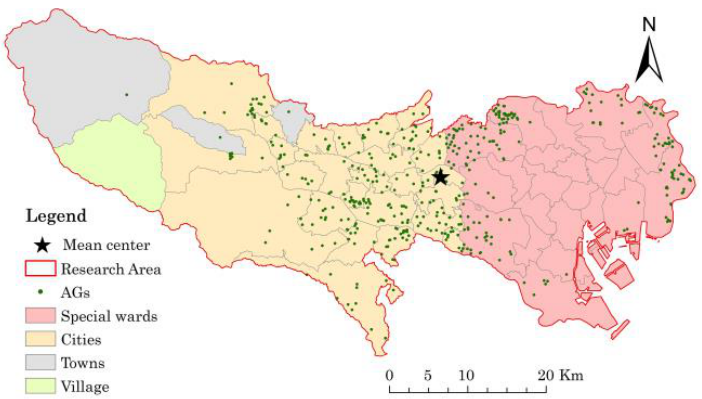
Figure 8. Mean center.